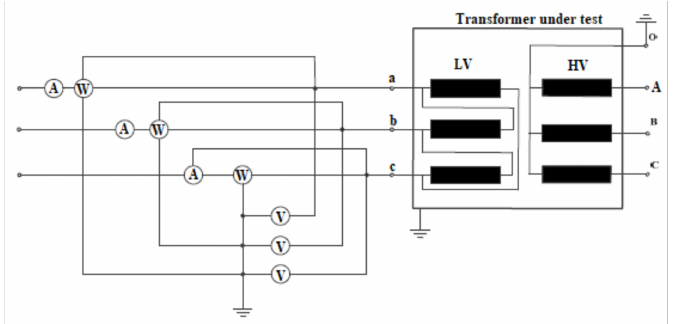
Figure 4. No-load loss test arrangement drawing.